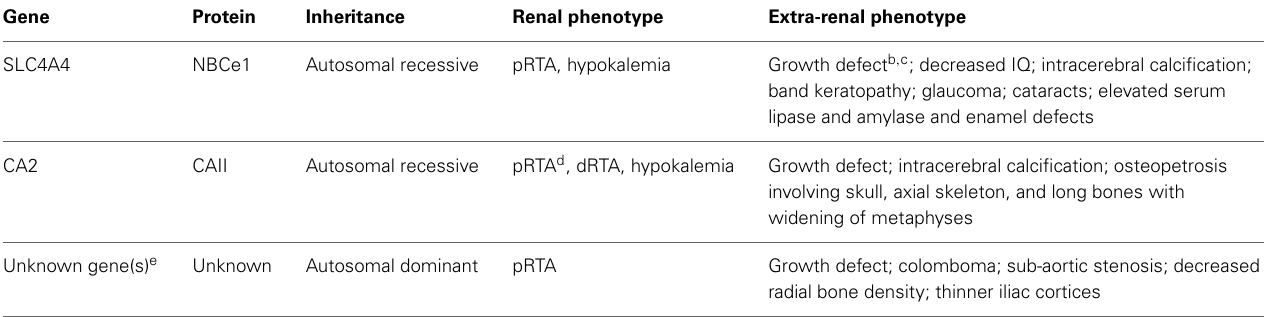
Table 2 | Hereditary a proximal renal tubular acidosis.